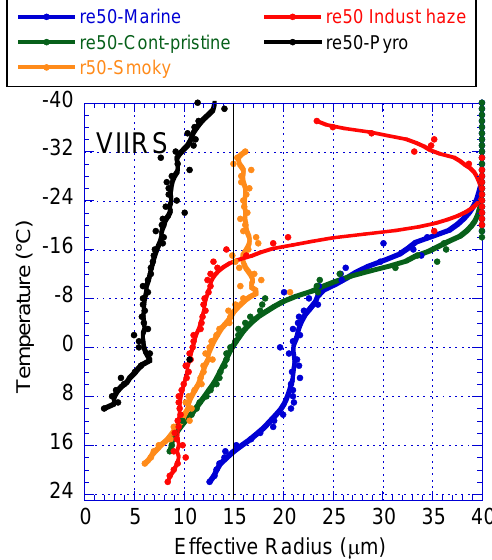
Fig. 25. The T – r e relations of all the types of deep convective cloud in this